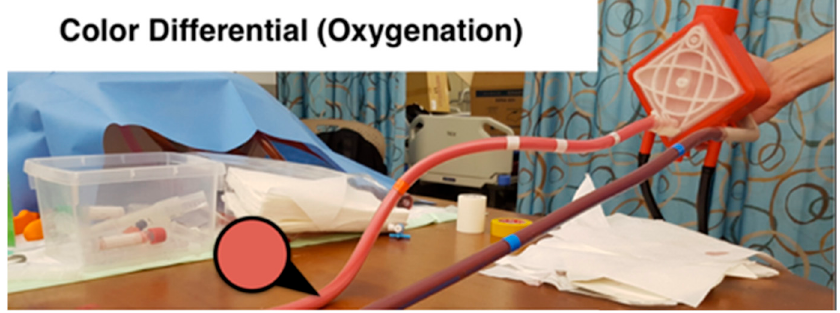
Figure 14. Thermochromic loop being tested at HMC.